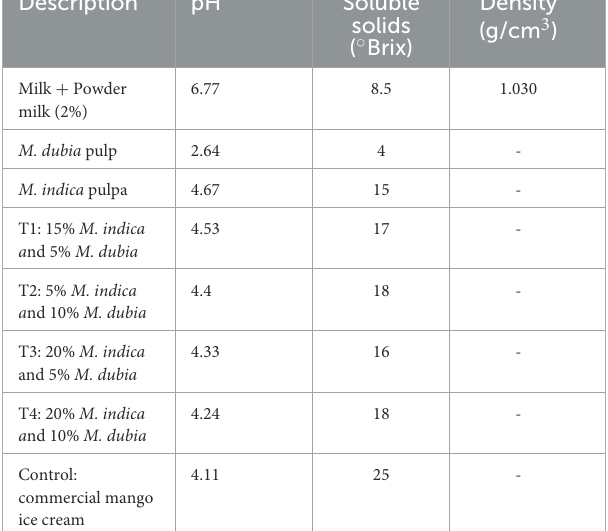
TABLE 3 Analysis of milk, M. indica pulp, M. dubia pulp and ice creams. Description pH Soluble